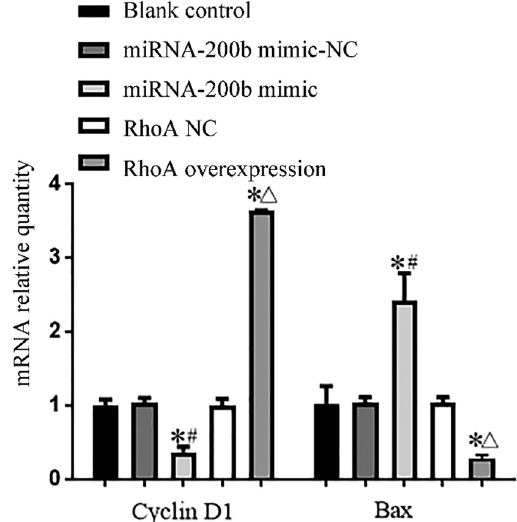
Figure 6: Comparison of cyclin D1 and Bax gene mRNA expression levels in each group. Note: compared with blank control group, * P < 0.05; compared with mimic - NC group, # P < 0.05; and compared with RhoA NC group, Δ P <